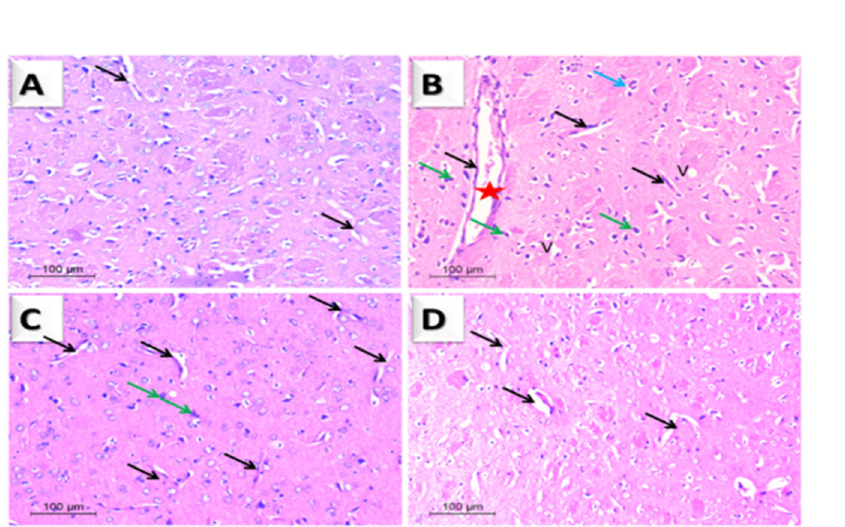
Fig 9. Photomicrographs of rat striatum (H & E, 100). ( A ) normal neurons with some blood vessels as a control (black arrows). ( B ) Rotenone (positive control group): epineuronal vacuolation (v), dilated blood vessel congested (star), and vacuolated neuropil (blue arrow) pyknotic neuclei neuron (green arrows). ( C ) Rotenone + Yucca 50mg/kg: pyknotic (green arrows) and vascularization remain (black arrow). ( D ) Rotenone + yucca 100 mg/kg: nearly normal tissue with a small number of blood vessels (black arrow).